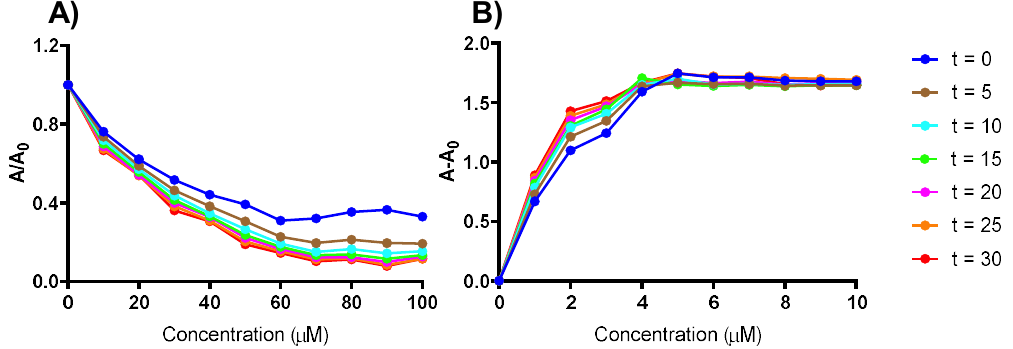
Figure 3. Study of the antioxidant activities in a wide range of concentrations and times (t). ( A ) Free ferulic acid, evaluated by DPPH assay; ( B ) compound G 1 -[Si(CH 2 ) 3 NH(CO)Ph(OH) 3 ] 4 (3), evaluated by FRAP assay.